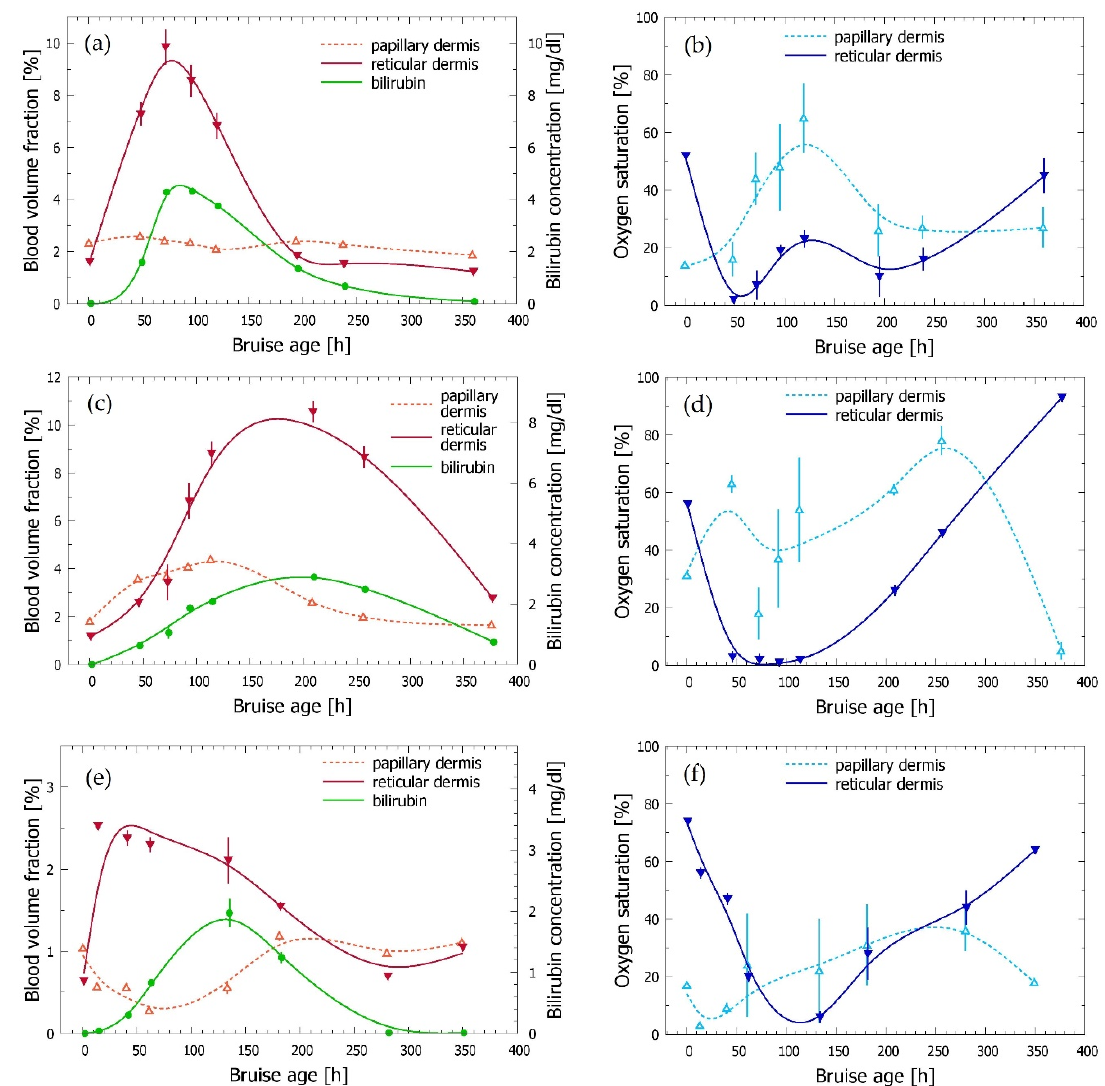
Figure 8. Temporal evolution of the bruise model parameters with bilirubin present in both epidermis and dermis as assessed from measurements in subjects a panels ( a , b ), b ( c , d ), and c ( e , f ). The curves serve only as a guide to the eye. The error bars represent standard deviations from 6 IMC runs.